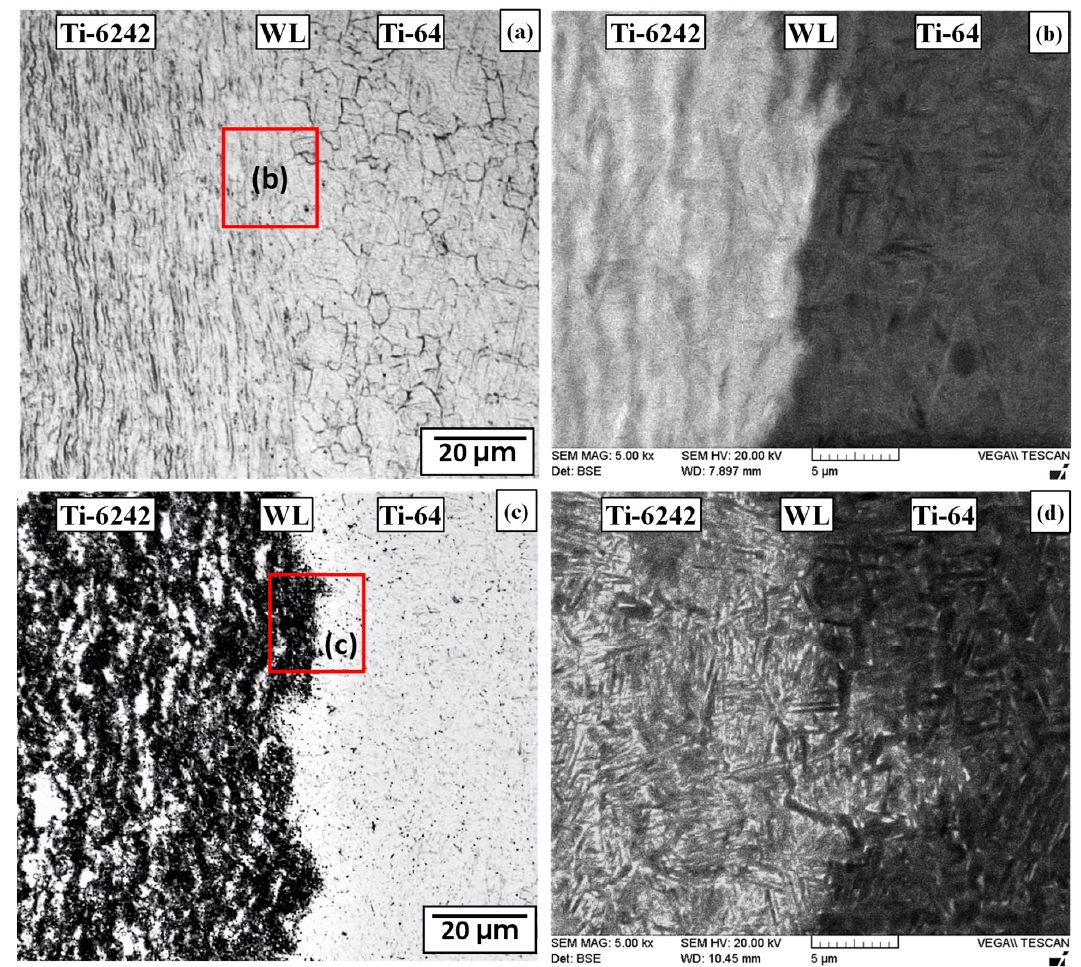
Figure 7. Microstructures in central weld zone (CWZ) on either side of the weld line (WL) separating the Ti-6242 and Ti-64 sides ( a , b ) AWed (OM and SEM) ( c , d ) SRAed (OM and